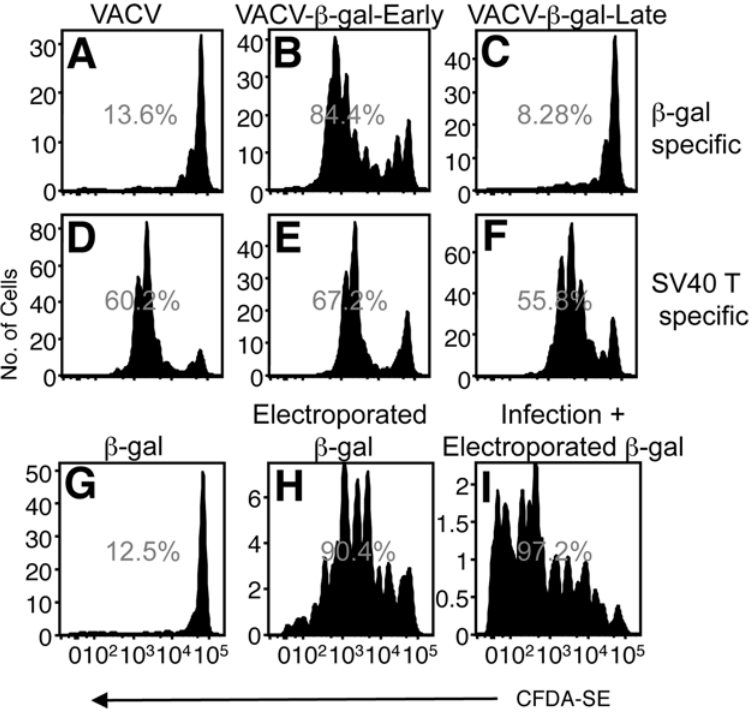
Figure 5. VACV infection does not inhibit the cross presentation of cellular antigen. Proliferation of adoptively transferred CFDA-SE labeled b -gal-specific (A–C) or SV40 TAg Site I-specific (D–F) TCR transgenic T CD8 + was measured following immunization with TAg- b 2 m neg cells infected with VACV that does not express b -gal (A,D), rVACV- b -gal-Early (B,E), or rVACV- b -gal-Late (C,F). Proliferation of adoptively transferred b -gal- specific (G–I) TCR transgenic T CD8 + was measured following immunization with TAg- b 2 m neg cells incubated with 1 mg/mL b -gal (G), electroporated with 1 mg/mL b -gal (H), or infected with rVACV for 5 h and electroporated with 1 mg/mL b -gal (I).